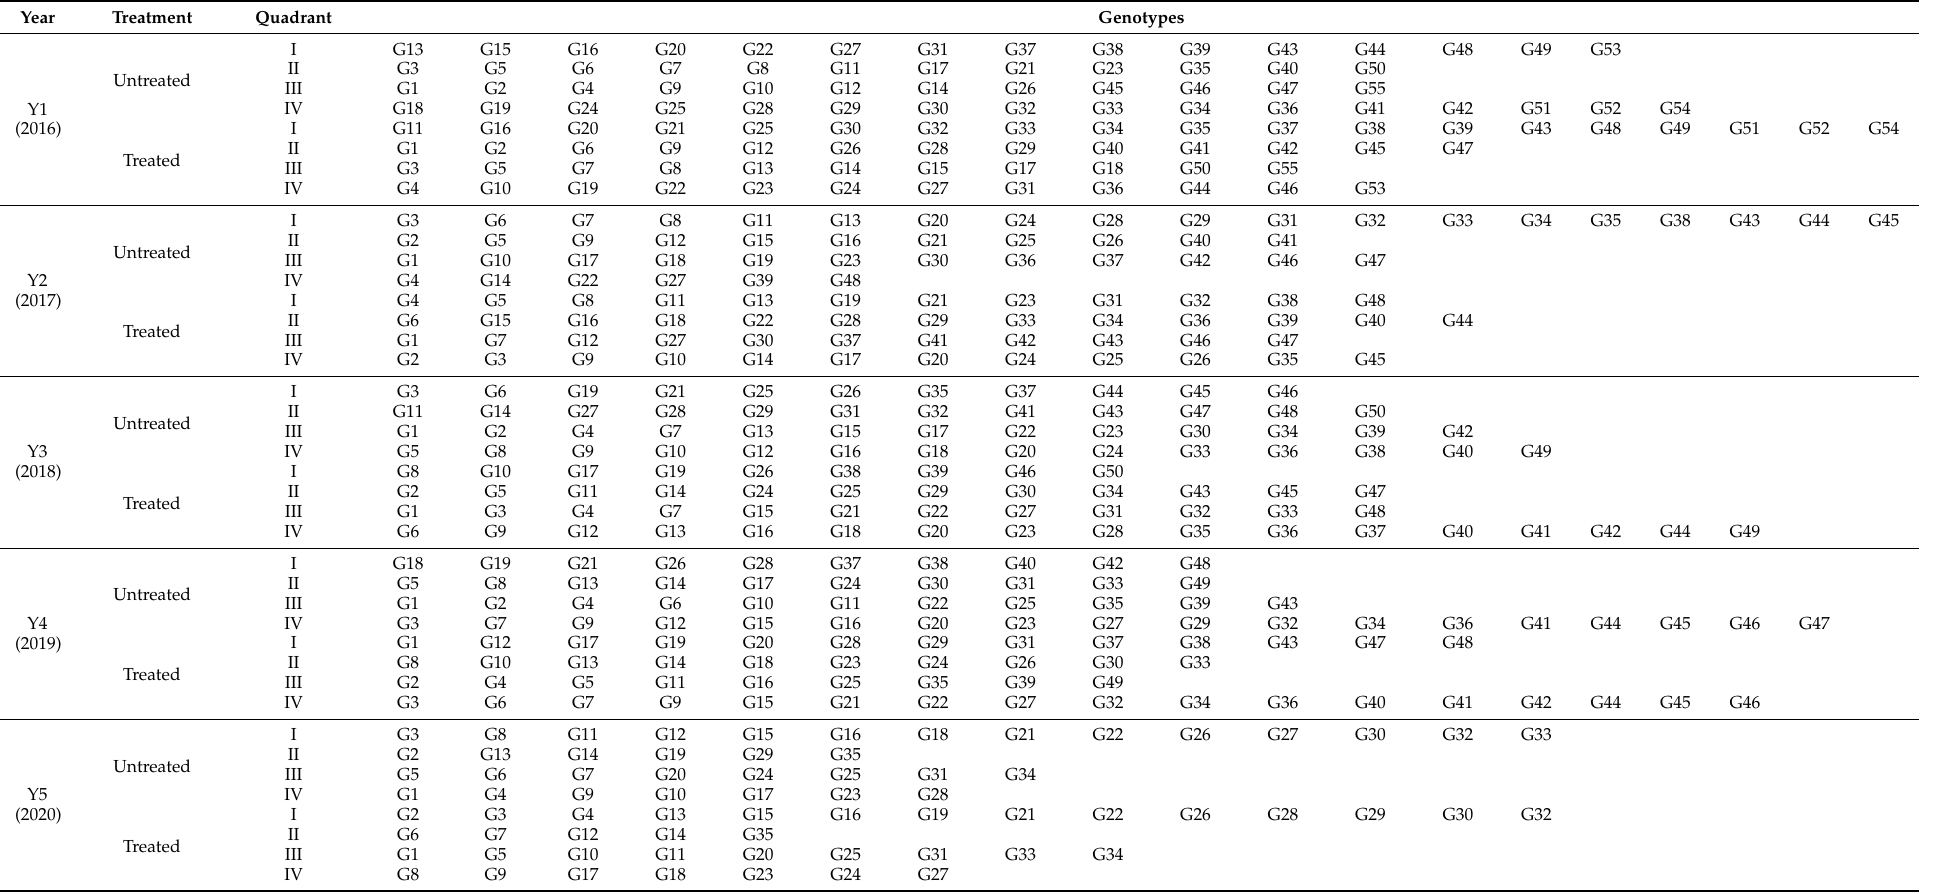
Table 3. Genotype classification from IPCA1 scores vs. grain